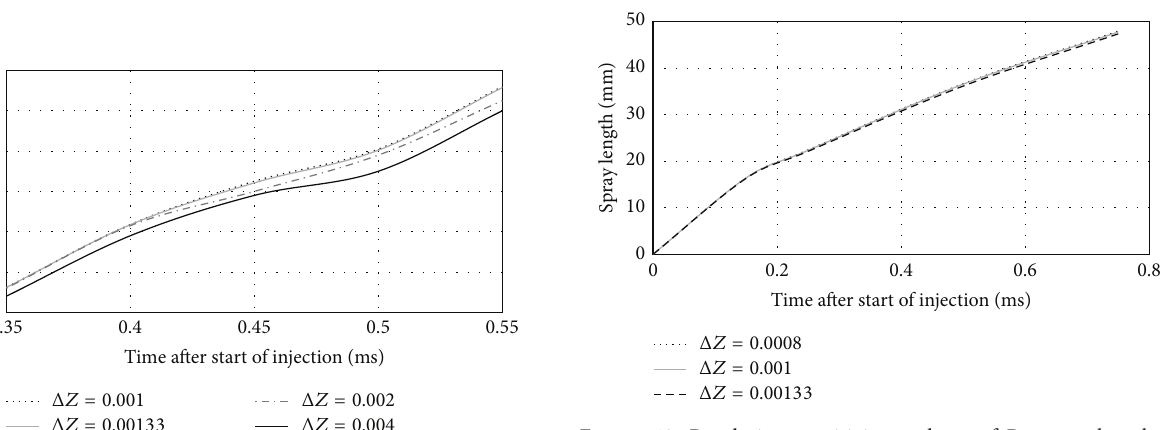
Figure 7: Comparison of numerical and experimental spray length of HFO at injection pressure of 1000 bar [23].